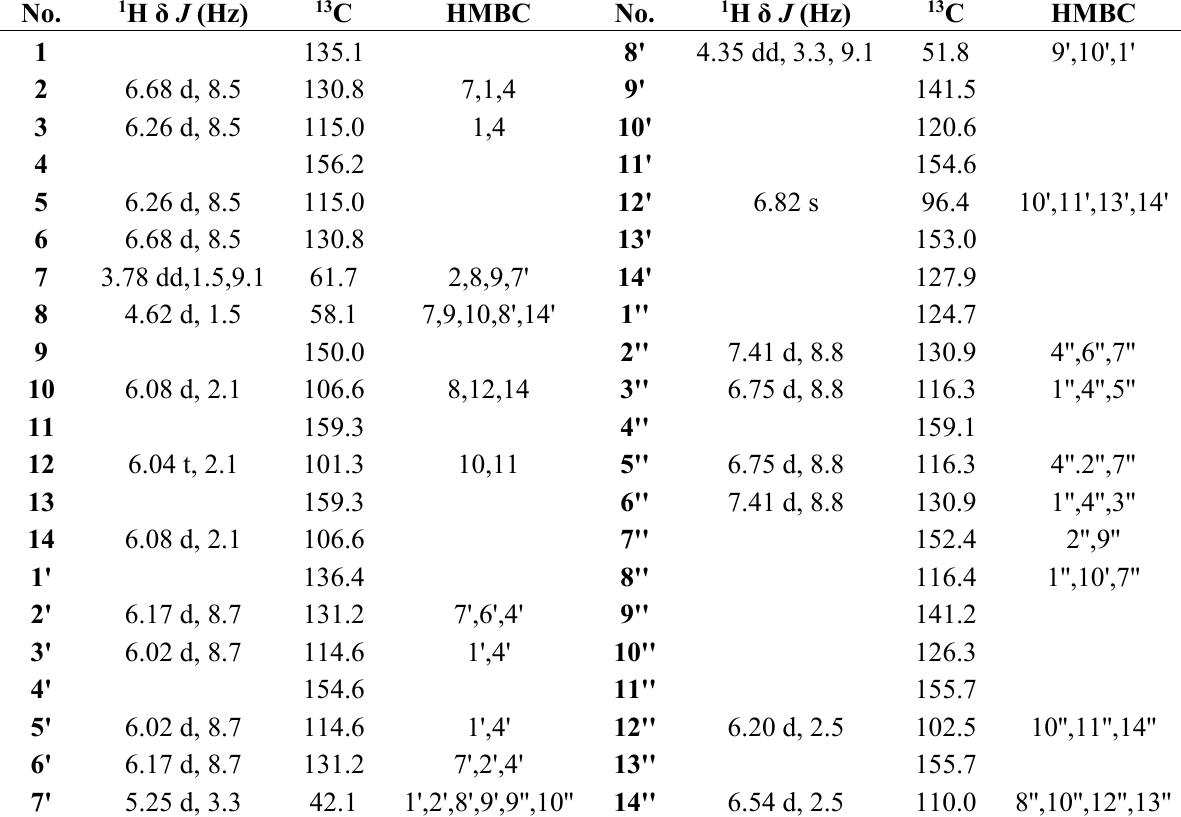
Table 1. 1 H- and 13 C-NMR data of 1 , together with HMBC (H → C) correlations. At 400/100 MHz, respectively, in CD 3 OD; δ in ppm, J in